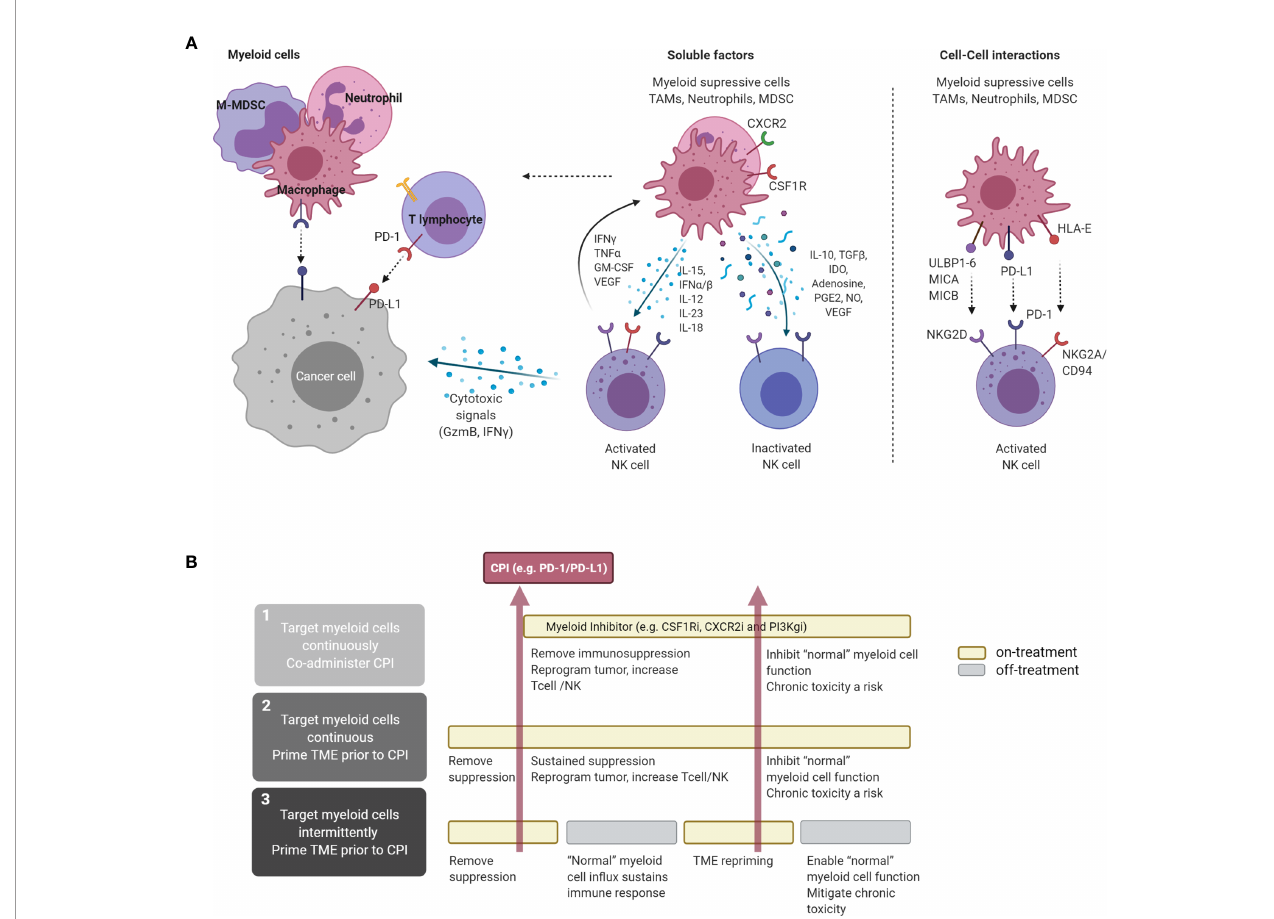
FIGURE 1 | Direct and indirect interaction of NK and myeloid cells in the TME and therapeutic concepts. (A) Interaction of NK and myeloid cells in the TME. NK cells can directly target tumor cells via cytolytic granules, independent of antigen recognition. Macrophages with immunostimulatory properties can independently induce tumor-cell killing through antigen presentation and production of pro-in fl ammatory cytokines. In the TME, myeloid cells, including TAMs, M-MDSCs, neutrophils, and PMN-MDSCs, can secrete a variety of soluble factors that inhibit NK activation and therefore suppress NK-mediated cytotoxicity. Cytokines secreted by NK cells (e.g., IFN g , TNF a , and GM-CSF) can stimulate macrophages, driving a pro-in fl ammatory activated state. These two cell types can also interact at the receptor level, where myeloid cell-surface ligand and NK receptors interact, attenuating downstream signaling, e.g., NKG2D. (B) Proposed therapeutic approaches targeting myeloid-cell subsets in the TME and proposed alternative treatment sequences that can be explored to maximize immune-mediated anti-tumor response. CPI, checkpoint inhibitor. Figure created with